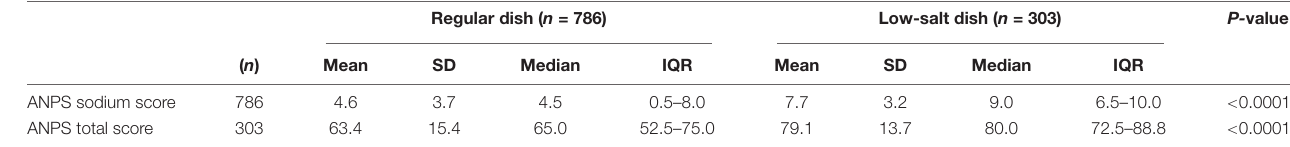
Values are expressed as the mean, standard deviation (SD), median, interquartile ranges (IQRs). Regular and low-salt dishes were compared using the Mann–Whitney U